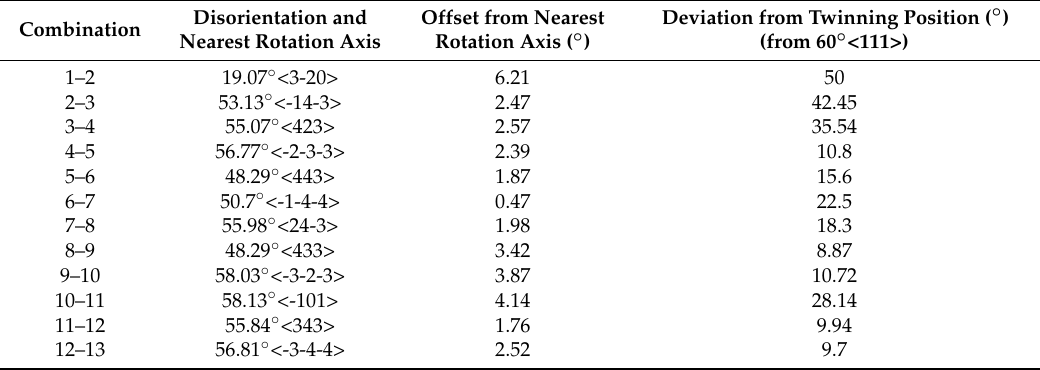
Table 4. Orientation relationships between twin and matrix for the 13 grains shown in Figure